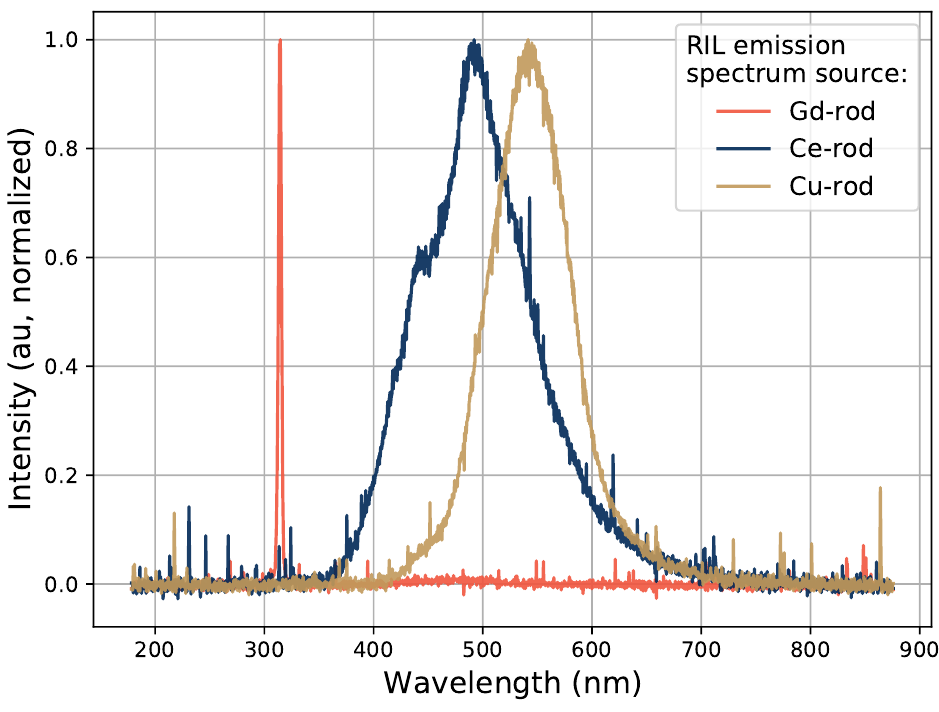
Figure 5. RIL emission spectra taken from the different sample